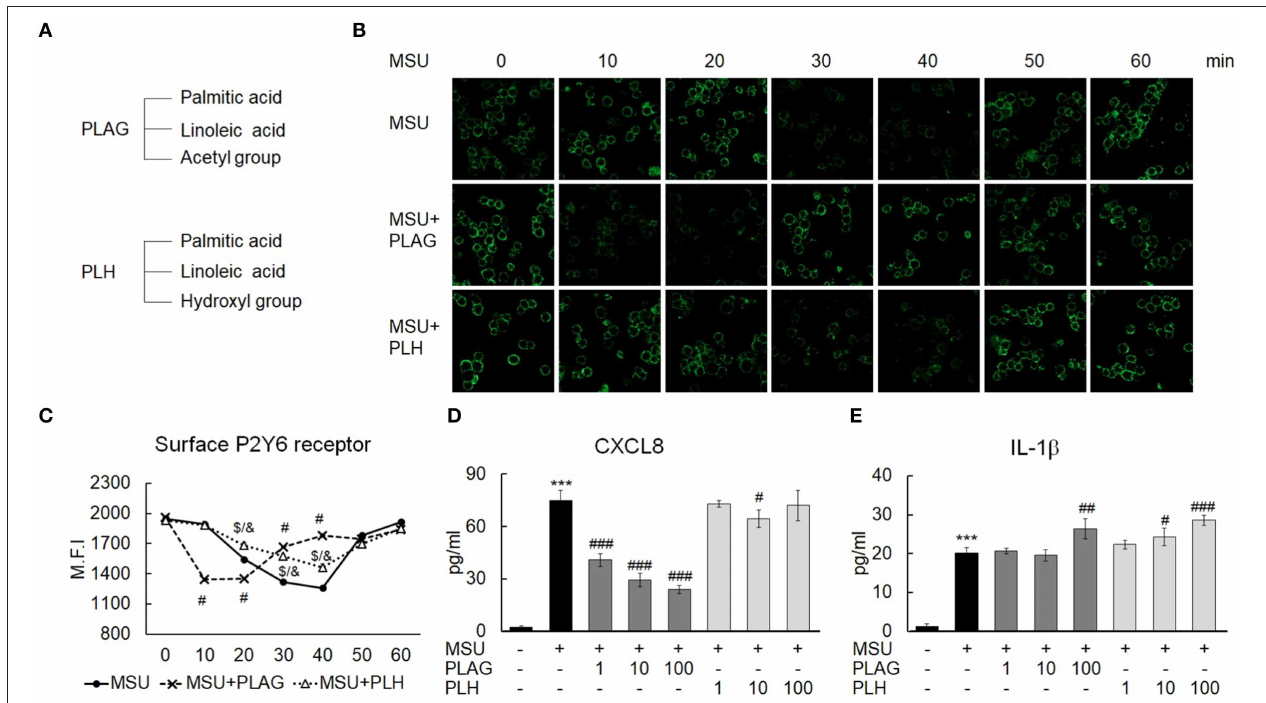
FIGURE 7 | Specificity of PLAG in accelerated P2Y6 endocytosis and the modulation of CXCL8 expression. (A) Chemical structure of PLAG and PLH. (B) Advanced endocytosis by PLAG was compared with that by PLH. Cells were incubated with 100 µ g/ml PLAG, PLH, or DMSO for 1h and then stimulated with 200 µ g/ml of MSU crystals. The cells were harvested over time were fixed using 4% paraformaldehyde. P2Y6 receptor expressed on the membrane was stained with the P2Y6 receptor antibody without permeabilization and was analyzed using confocal microscopy. (C) The result of B was also confirmed by flow cytometry. (D,E) PLAG was compared with PLH to check the secretion levels of CXCL8 and IL-1 β . The cells were incubated with 100 µ g/ml PLAG, PLH, or DMSO for 1h and were treated with 200 µ g/ml MSU crystals for 24h. The culture supernatants were harvested and used for ELISA. Data are presented as mean ± SD. *** p < 0.001, compared to the control group; # p < 0.05, ## p < 0.01, ### p < 0.001, statistical difference between the MSU-treated group and MSU + PLAG treated group; $p < 0.05, statistical difference between the MSU-treated group and MSU + PLH treated group; & p < 0.05, statistical difference between the MSU + PLAG-treated group and MSU + PLH-treated